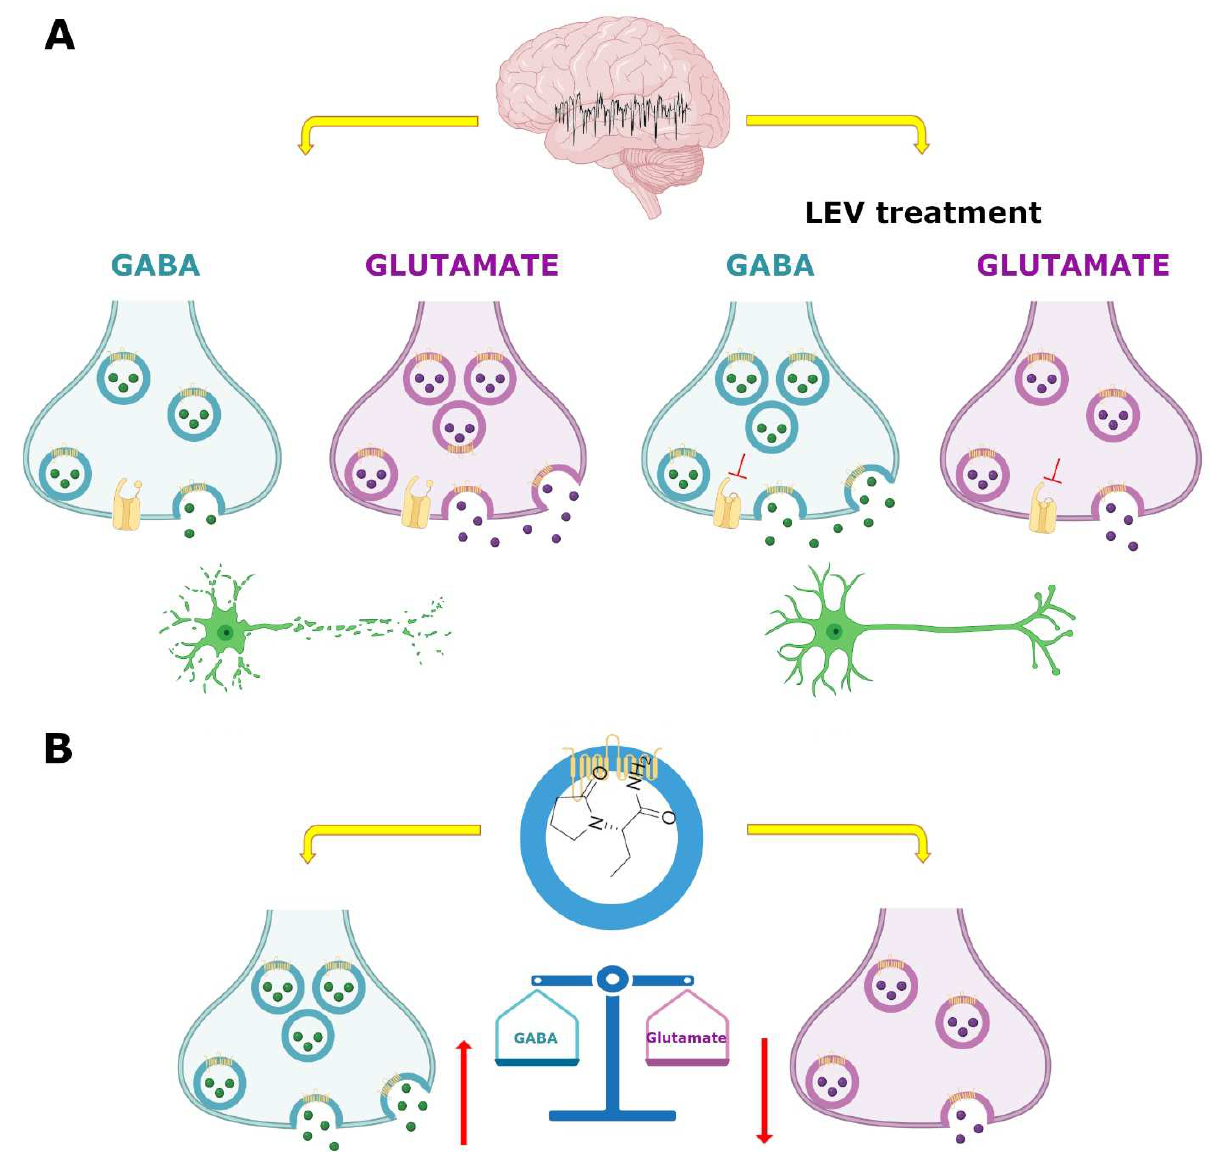
Figure 5. Hypothetical acti-ictogenic and neuroprotector effect of levetiracetam (LEV). ( A ) The anti-ictogenic effect of LEV seems to be an integrative mechanism, that involved the interaction to this AED with different pharmacological targets, resulting in a decrease in the excitability in the epileptic circuit. Although the exact mechanism throughout LEV can decrease the excitability remain unclear, the evidence suggests that SV2A plays a critical role. In epileptic nerve terminal, the binding LEV-SV2A could result in augment or decrease in neurotransmitter release. Moreover, LEV blocks the voltage calcium and decreases the release of the neurotransmitters. ( B ) GABA and glutamate are the principal neurotransmitters responsible for maintaining a balance between inhibition and excitation, respectively. In epilepsy, as well as in other pathologies that cause neuronal damage, there is an imbalance between these systems, which results in increased excitability and neuronal death. LEV decreases both events, perhaps by modulating neurotransmitter release by binding to SV2A, which may result in increased neurotransmitter release, particularly GABA, or in a decreased of neurotransmitter release, particularly glutamate. Regardless, whether LEV particularly increases GABA release or decreases glutamate release, the final effect is decreased excitability, seizures, and neuronal death by restored the balance between excitatory and inhibitory